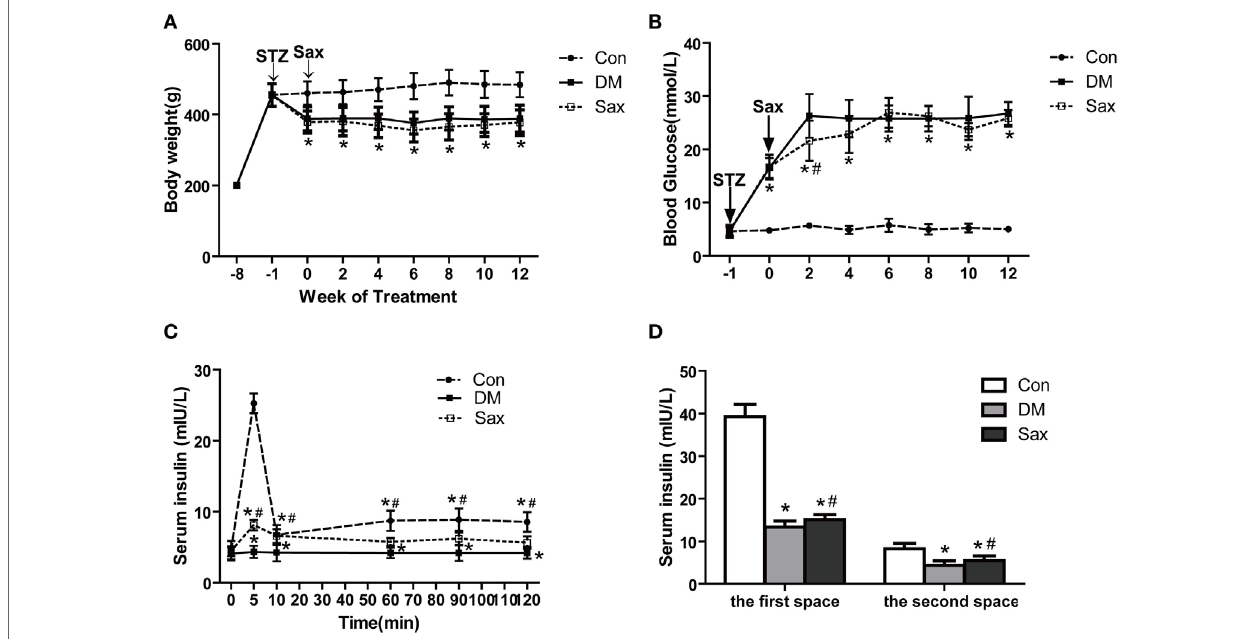
FigUre 1 | Effects of saxagliptin on body weight, blood glucose, and islet function in high-fat diet/STZ-induced diabetic rats. Body weight was measured every 2 weeks (a) . Blood glucose levels were measured every 2 weeks ( n = 7–10 in each group) (b) . Insulin secretion levels during hyperglycemic clamp ( n = 3 in each group) (c) . The first and second phase of insulin secretion of each group (D) . The first-phase insulin secretion levels were the sum of the insulin levels of 5 and 10 min after venous glucose loading. Similarly, the second-phase insulin secretion levels were the average plasma insulin levels of 60, 90, and 120 min after venous glucose loading. Data were reported as mean ± SEM. * p < 0.05 compared with the control group, # p < 0.05 compared with DM group. Con, control group; DM, diabetes group; Sax, saxgliptin